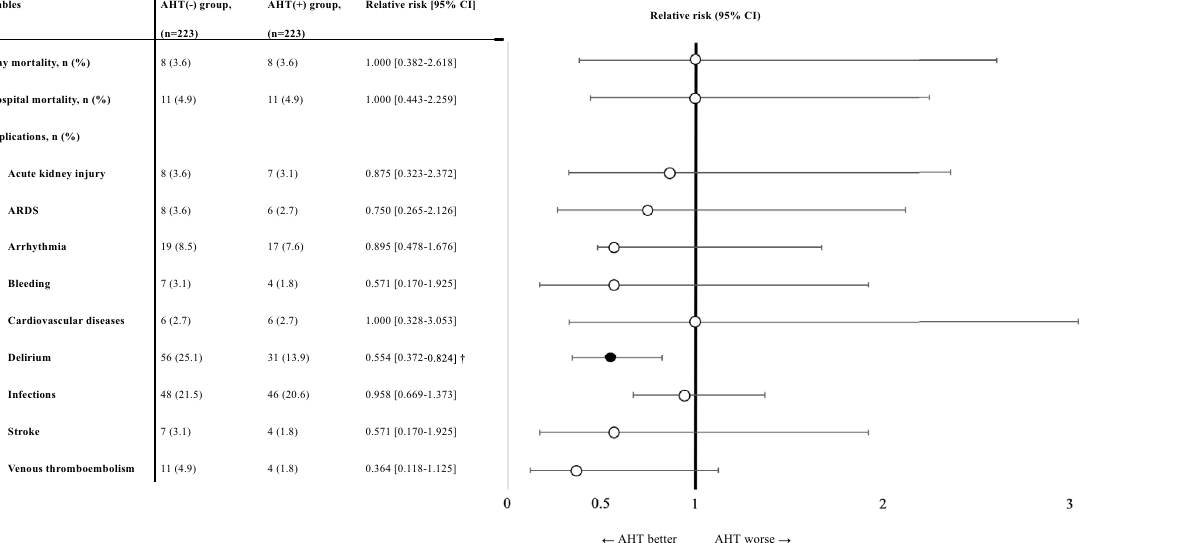
Figure 2. Primary and secondary outcome events. Relative risks of each outcome. Horizontal bars show 95% CIs. A thick vertical line represents a relative risk of 1.0, indicating no significant difference in outcome between AHT(−) and AHT(+) groups. † The results were statistically significant based on 95% CI, and a black circle plotted on the horizontal bar. Causes of death in the ATH(-) group were as follows: severe brain injury (n = 6), heart failure (n = 1), sepsis (n = 3), natural death (n = 1). Causes of death in the ATH(+) group were as follows: severe brain injury (n = 3), haemorrhage shock (n = 1), aortic dissection (n = 1), heart failure (n = 1),